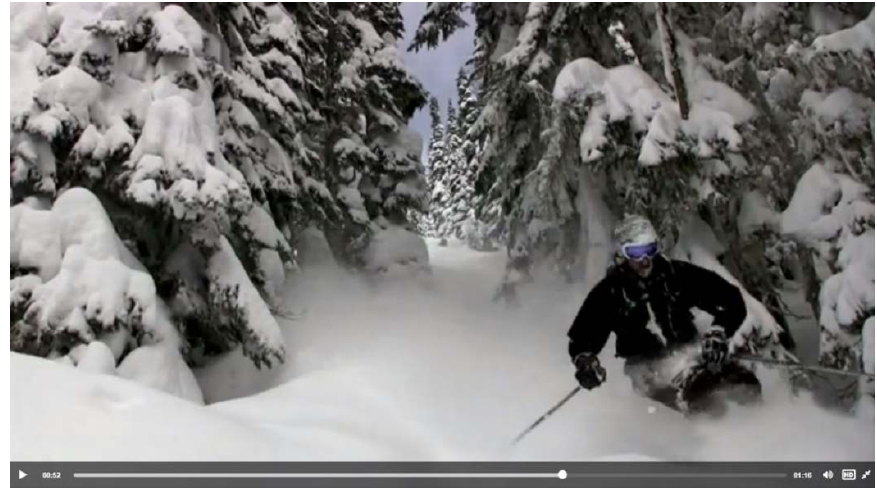
Figure 2. Still from the video Allure of the Backcountry .